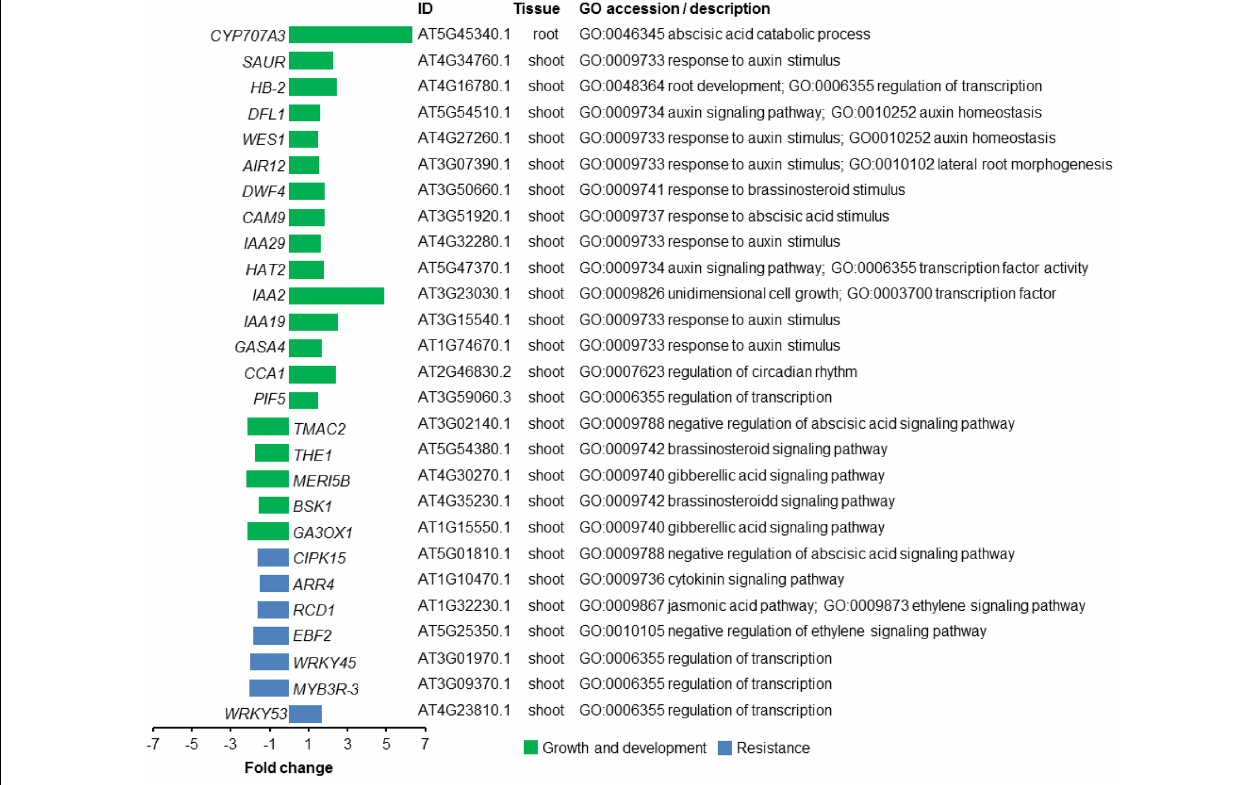
FIGURE 4 | Transcriptional changes in genes of A. thaliana exposed to volatile organic compounds (VOCs) from R. solani. Differentially expressed genes (DEGs) for seedlings exposed to the fungal VOCs are shown. Genes described to be involved in plant growth and development are depicted in green, whereas genes associated with resistance responses to biotic stress are depicted in blue. Gene Ontology (GO) description is based on the output from